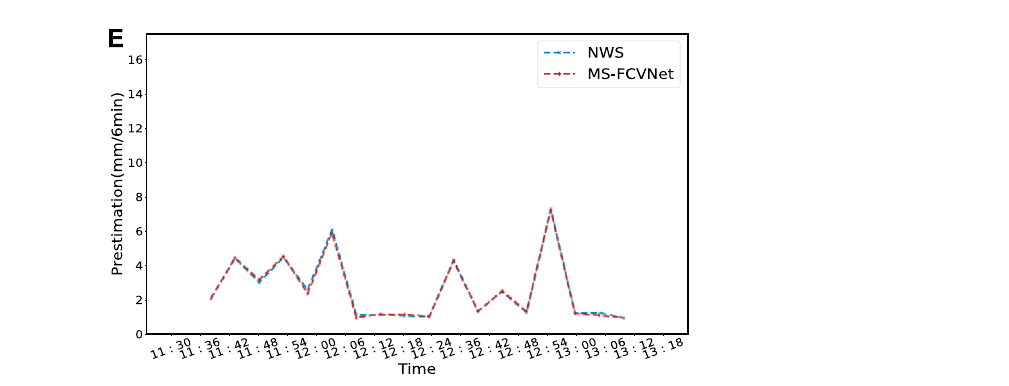
FIGURE 10 | Estimated values of models (A) Z-R relationship, (B) BPNN, (C) CNN (1), (D) CNN (2), (E) MS-FCVNet versus ground truth for the rainfall period from 11:30 to 13:18 on 12 August 2018.